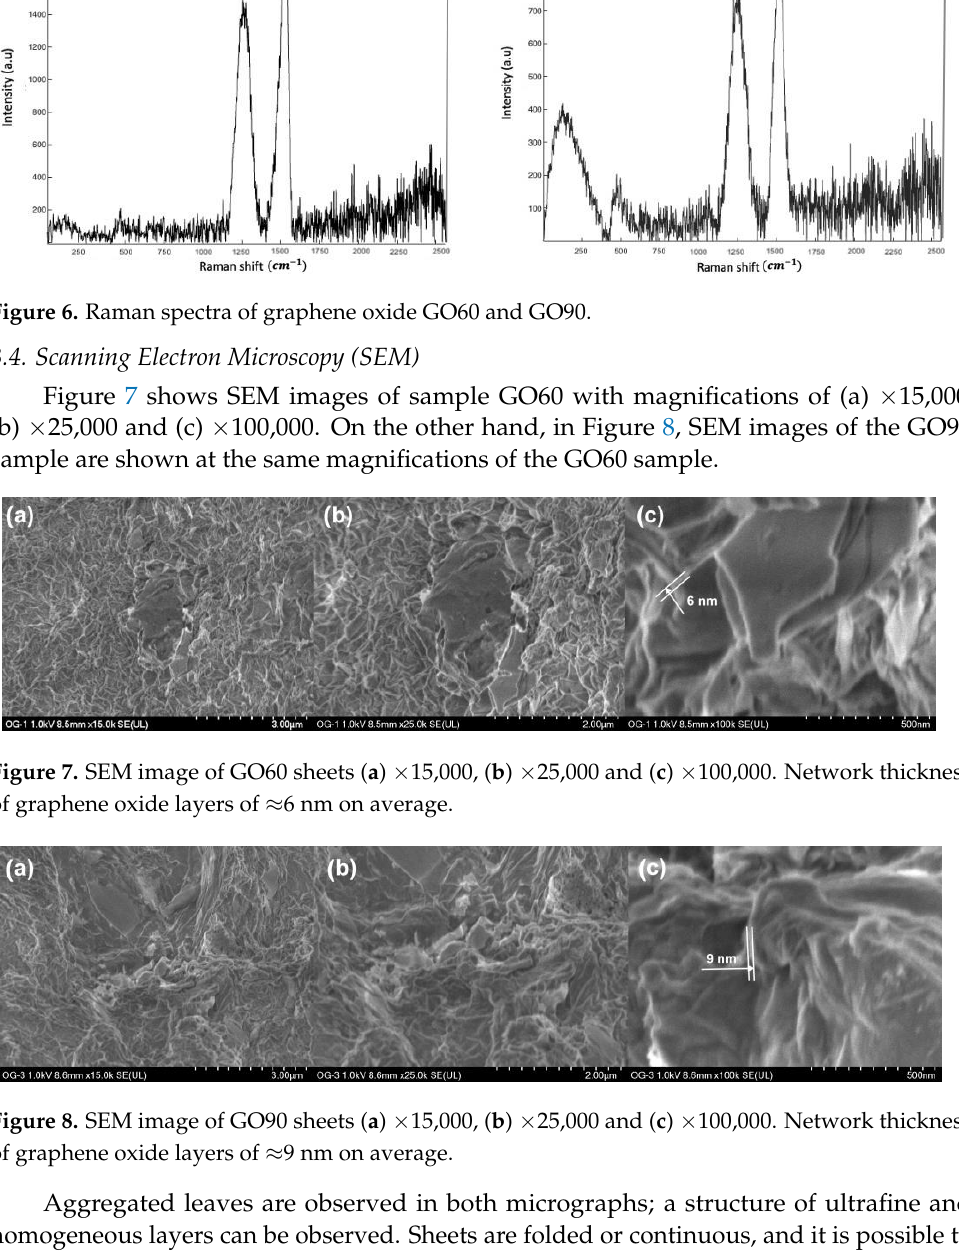
Figure 6. Raman spectra of graphene oxide GO60 and GO90.